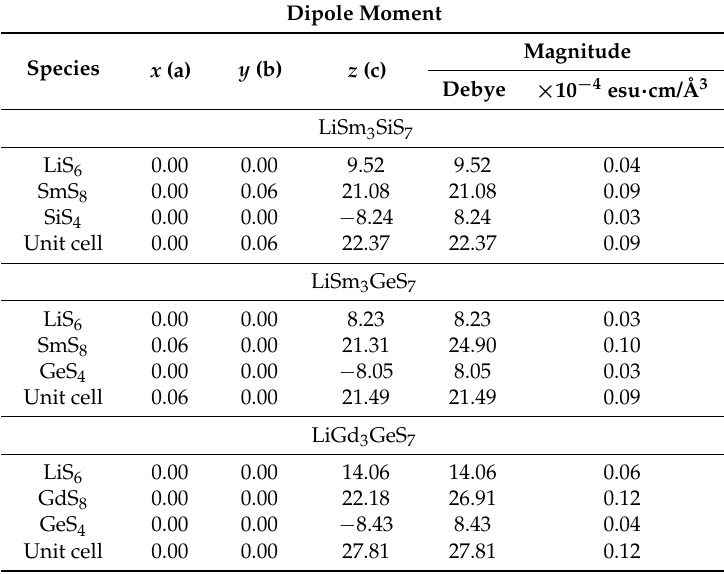
Table 4. Dipole moment calculations for LiRe 3 MS 7 (Re = Sm, Gd; M = Si,